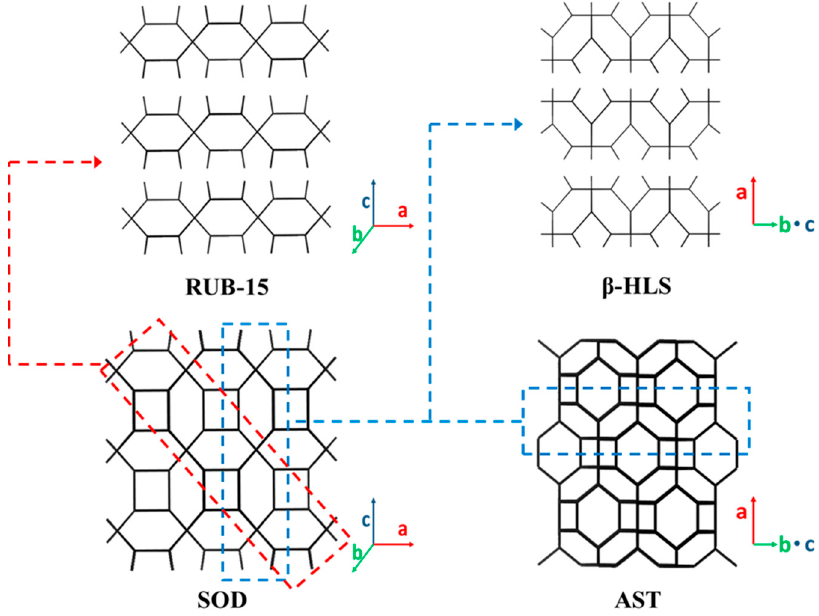
Figure 3. Schematic illustration and relationship between 2D layered silicates ( β -HLS ( β -helix-layered silicate) and RUB (Ruhr University Bochum)-15) and frameworks of 6-MR SOD (sodalite) and AST (aluminophosphate with sequence number sixteen) zeolites.